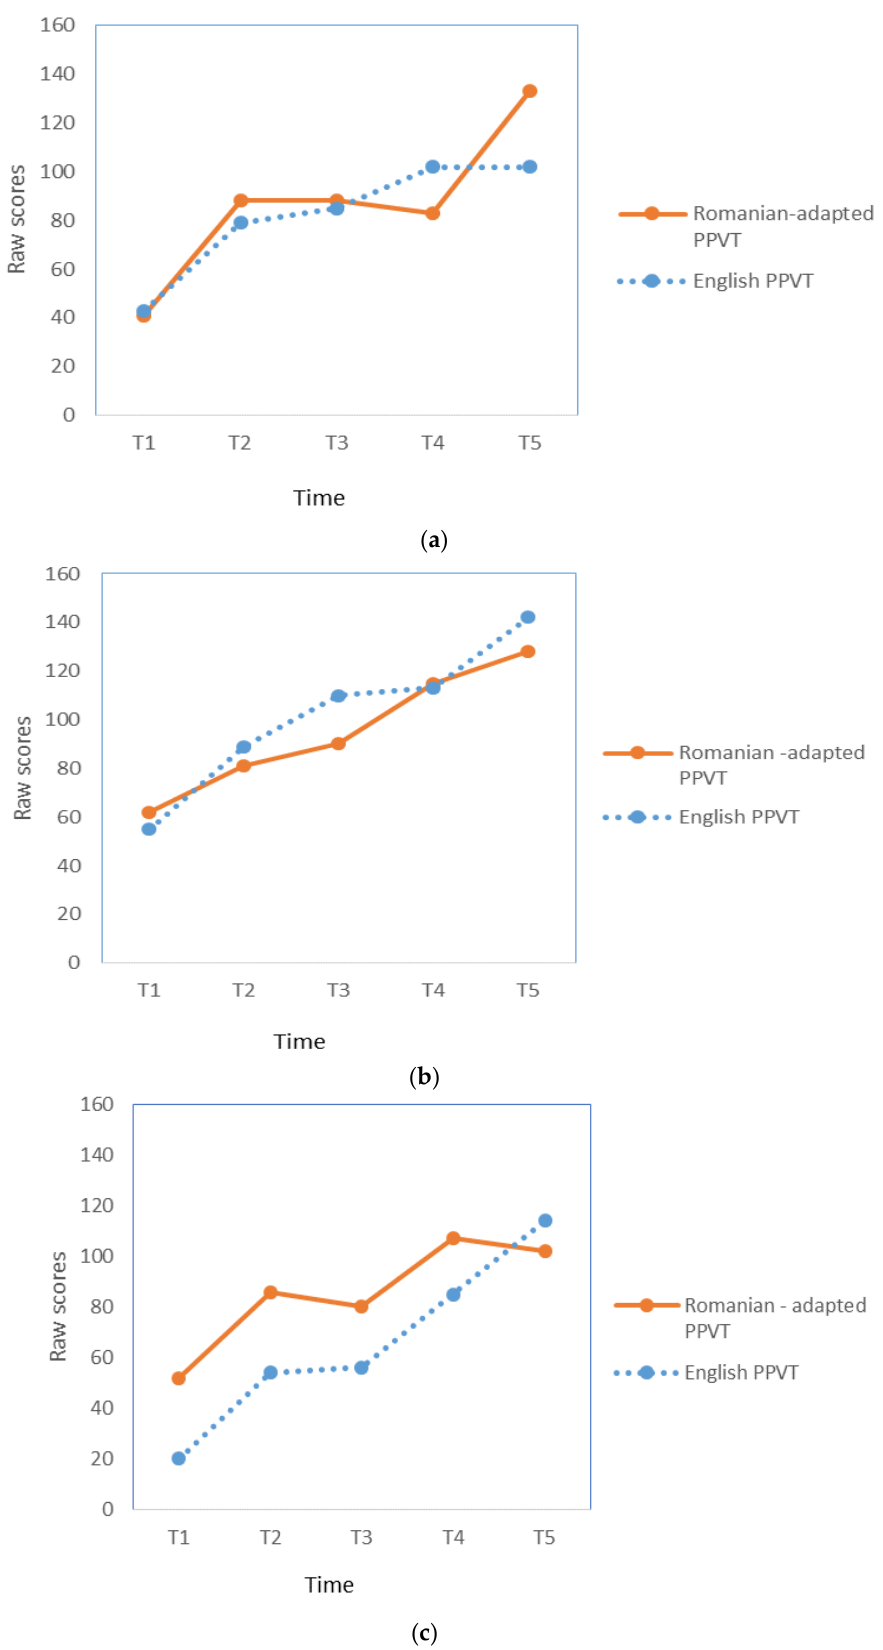
Figure 1. Peabody picture vocabulary test (PPVT)—raw scores for English and Romanian from T1 through T5 for ( a ) Dan; ( b ) Radu; and ( c ) Moni.